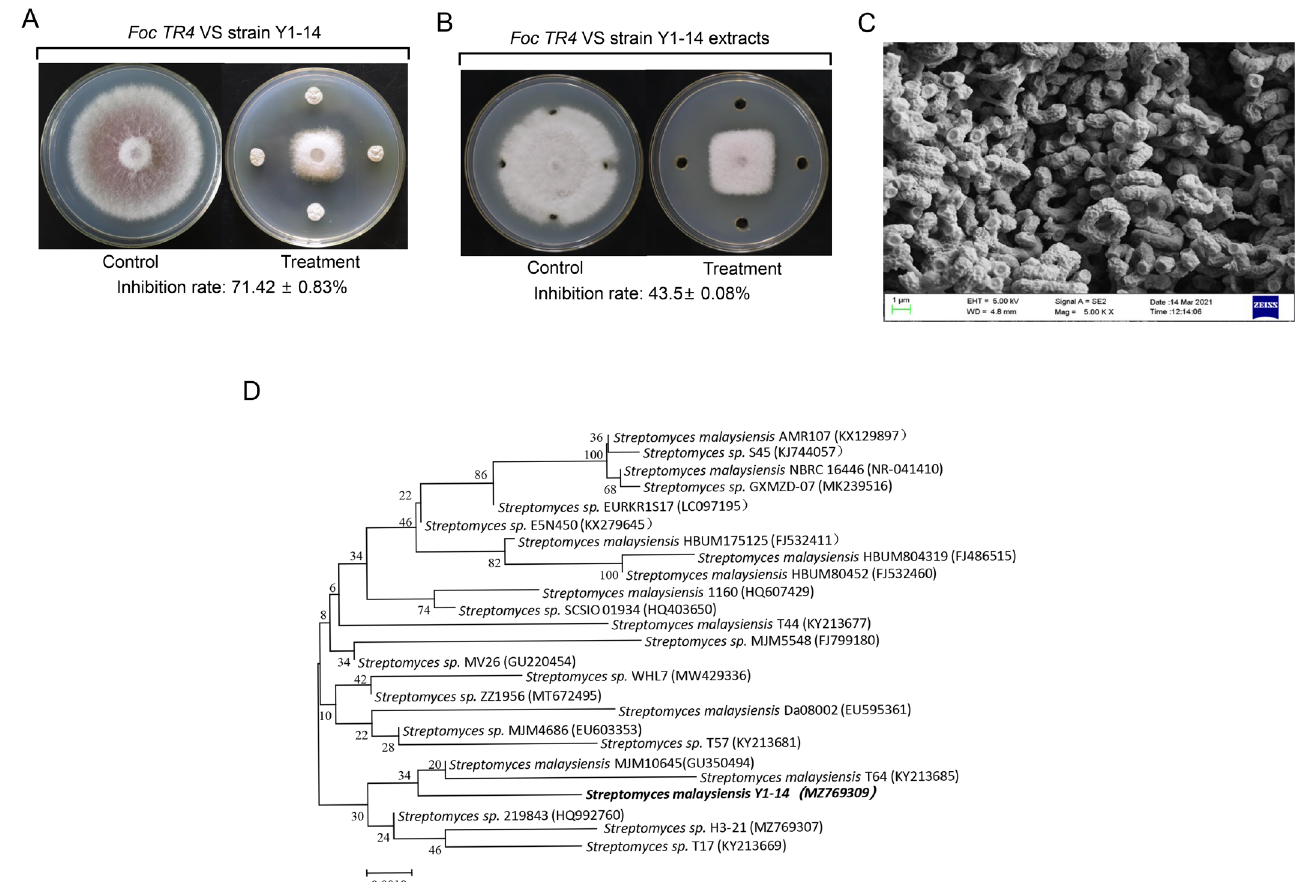
Figure 1. Isolation and identification of strain Y1-14 with strong antifungal activity against Foc TR4. ( A ) Strain Y1-14 inhibiting mycelial growth of Foc TR4. ( B ) Strain Y1-14 extracts inhibiting mycelial growth of Foc TR4. ( C ) Morphological characteristics of aerial mycelia and spores of strain Y1-14 using SEM. ( D ) Phylogenetic tree of strain Y1-14 based on 16S rRNA gene sequence analysis. The bootstrap values (%) at the branches were calculated from 1000 replications. Strain Y1-14 produced burlywood pigment on ISP4 medium and pink soluble pigment on ISP6 medium. Pigment was not detected on other selected medium (Supplementary Table